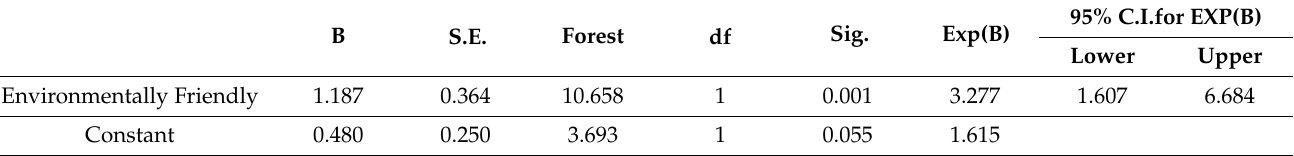
Table 3. Spanish sample. Output of logistic